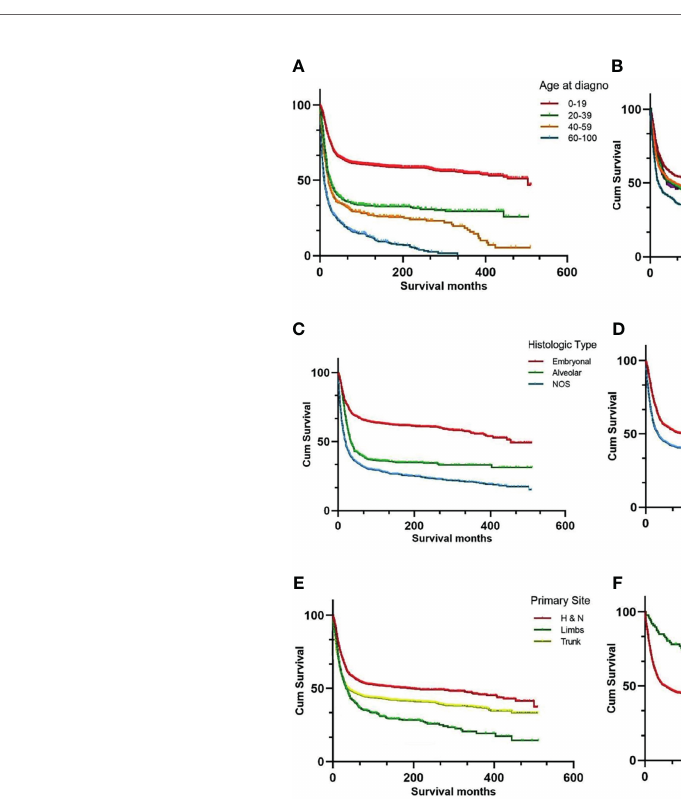
TABLE 2 | Demographic and clinical characteristics of SMNs with RMS by years.